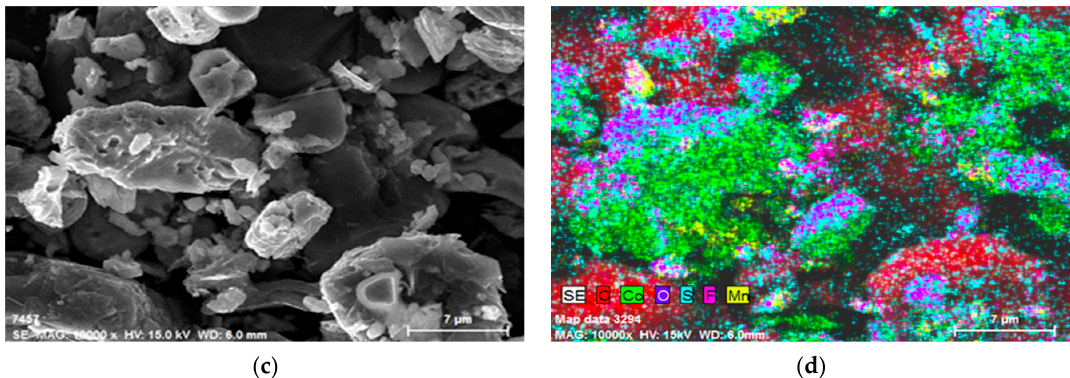
Figure 4. SEM images of sample 2, where ( a – c ) show different scales, while ( d ) is an EDS map of elements. The SEM images for sample 3 are presented in Figure 5. The morphology is different from samples 1 and 2. As can be seen in Figure 5a–c, the sample seems to be the most uniform, consisting of rough and compact structures. The objects present in the sample have a size from a few μ m to more than 10 μ m. The EDS map presented in Figure 5d reveals the elemental composition of the sample, showing large areas of carbon, looking like the substrate and objects that contain cobalt, oxygen, fluoride and even some nitrogen or their compounds. As visible, the surface of carbon is covered uniformly with sulfur that comes from the sulfuric acid during the leaching process.